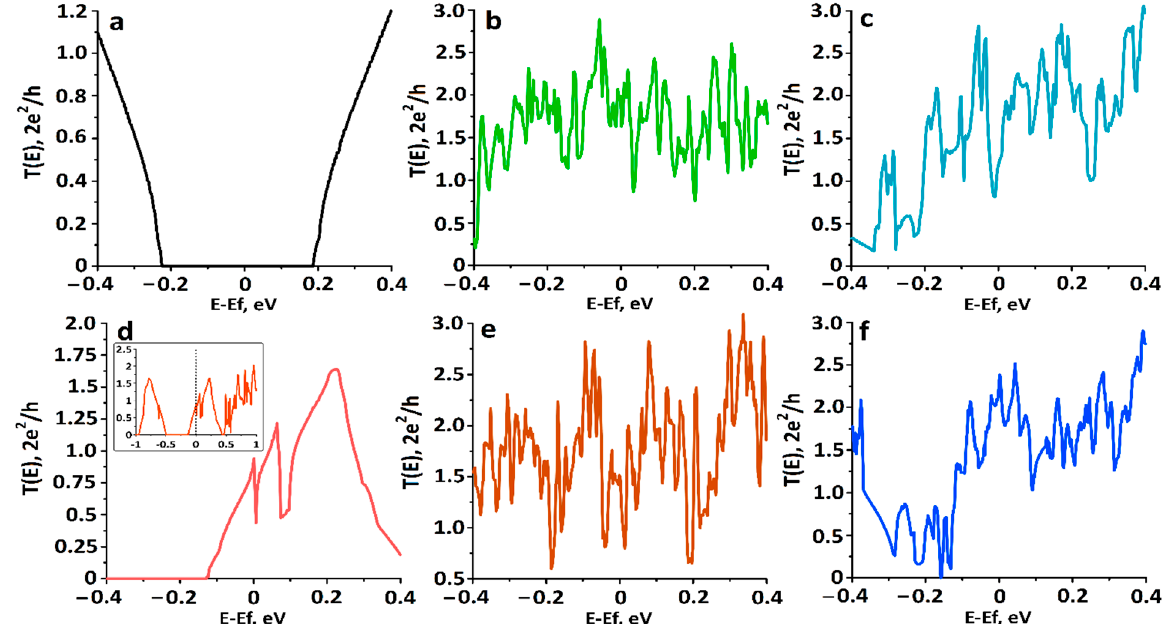
Figure 6. Transmission functions for ( a ) pure graphene–CNT composite; ( b ) composite filled with Li; ( c ) composite filled with Na; ( d ) composite filled with Si; ( e ) composite filled with Si–Li; and ( f ) composite filled with Si–Na.